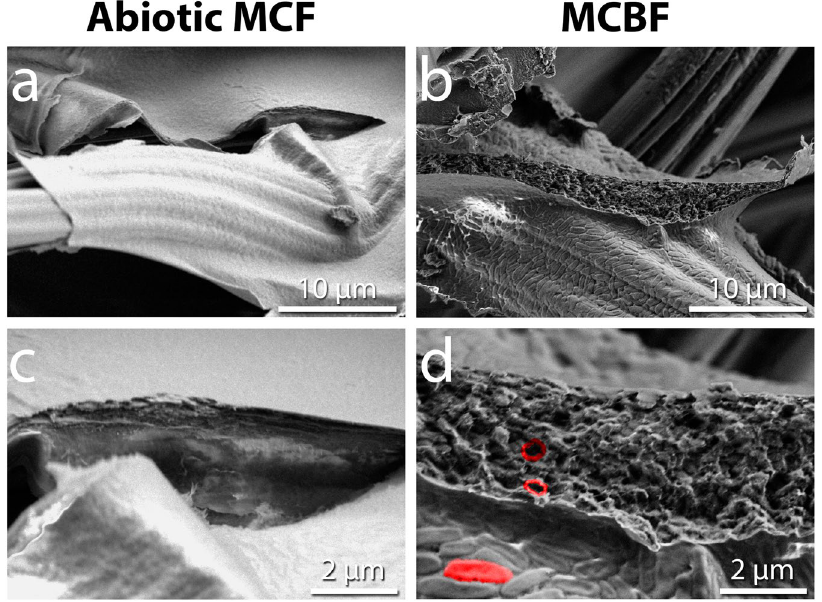
Figure 4. Electropolymerization of living S. oneidensis MR-1 embeds the bacteria inside a multilayer conductive bacterial-composite film. Scanning electron micrographs of a section of ( a and c ) an abiotic multilayer conductive film (MCF) showing smooth internal surfaces of PEDOT:PSS on CF, and ( b and d ) of an MCBF showing high density of bacteria within PEDOT:PSS layers. ( d ) One bacterium on the external surface of the MCBF is shaded in red, while two bacteria-sized voids internal to the MCBF are outlined in